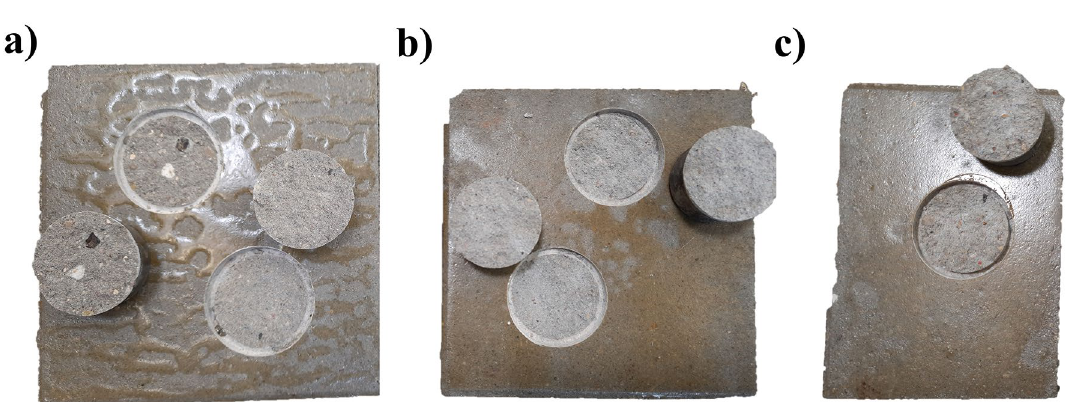
Figure 8. Adhesion tests in concrete samples with EP coating after 28 days of air-drying: ( a ) Oily substrate ( b ) Wet substrate ( c ) Dry substrate.